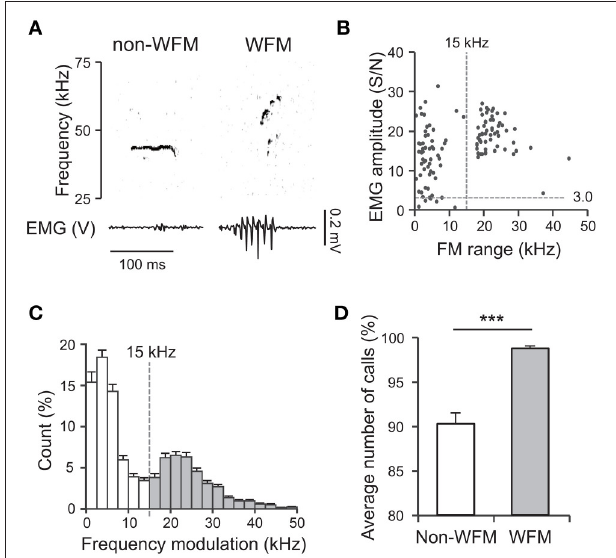
FIGURE 2 | Fifty kilohertz calls and TA EMG. (A) Examples of simultaneously recorded sonograms and TA EMGs acquired during recording sessions where subjects interacted with devocalized female rats (DF sessions) [left: a call with limited range frequency modulation (non-WFM call); right; a call with wide range frequency modulation (WFM call)]. (B) In a representative DF session, the relation between the range of frequency modulation (FM range) of 50-kHz calls and the maximum EMG amplitude around the calls. Each point represents a call. (C) The distribution of frequency modulation ranges of high frequency calls of all DF sessions. White bars: calls with frequency modulation < 15kHz (non-WFM calls); gray bars: calls with frequency modulation > 15kHz (WFM calls). Error bar: SEM. (D) The percentage of all non-WFM and WFM calls emitted with clear EMG activity (maximum amplitude > 3) over all DF sessions. Error bar: SEM. *** signifies p < 0.001, paired t